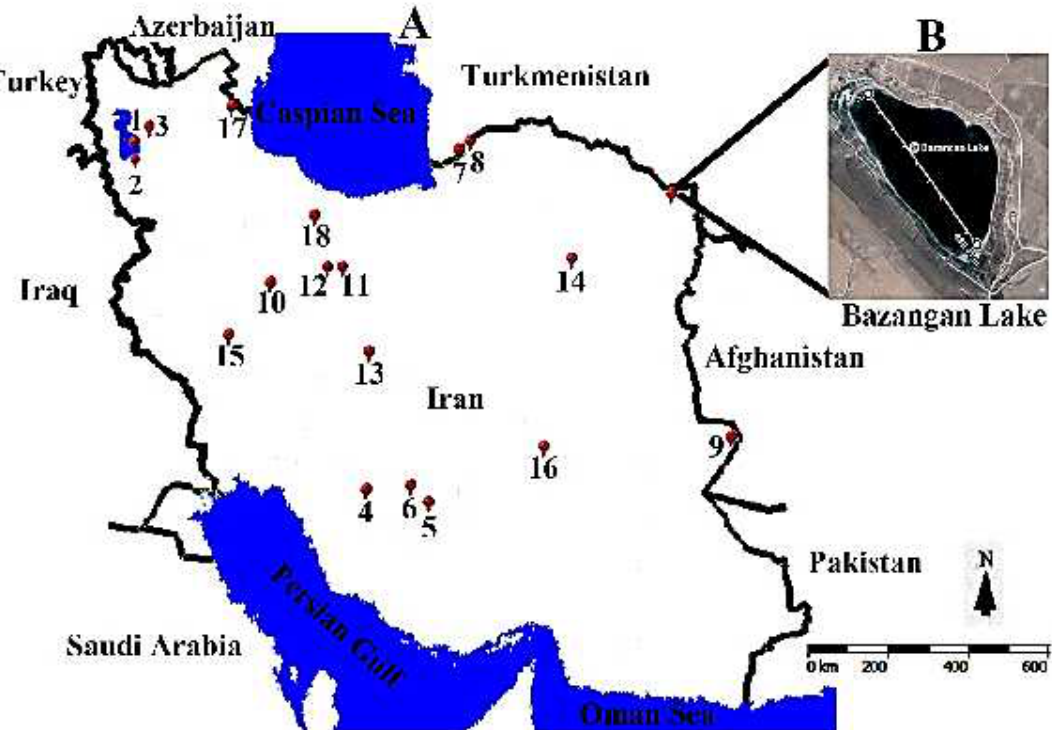
F IGURE 1. A. Distribution of Artemia in Iran. The Numbers indicate the Artemia Habitats. 1. Urmia